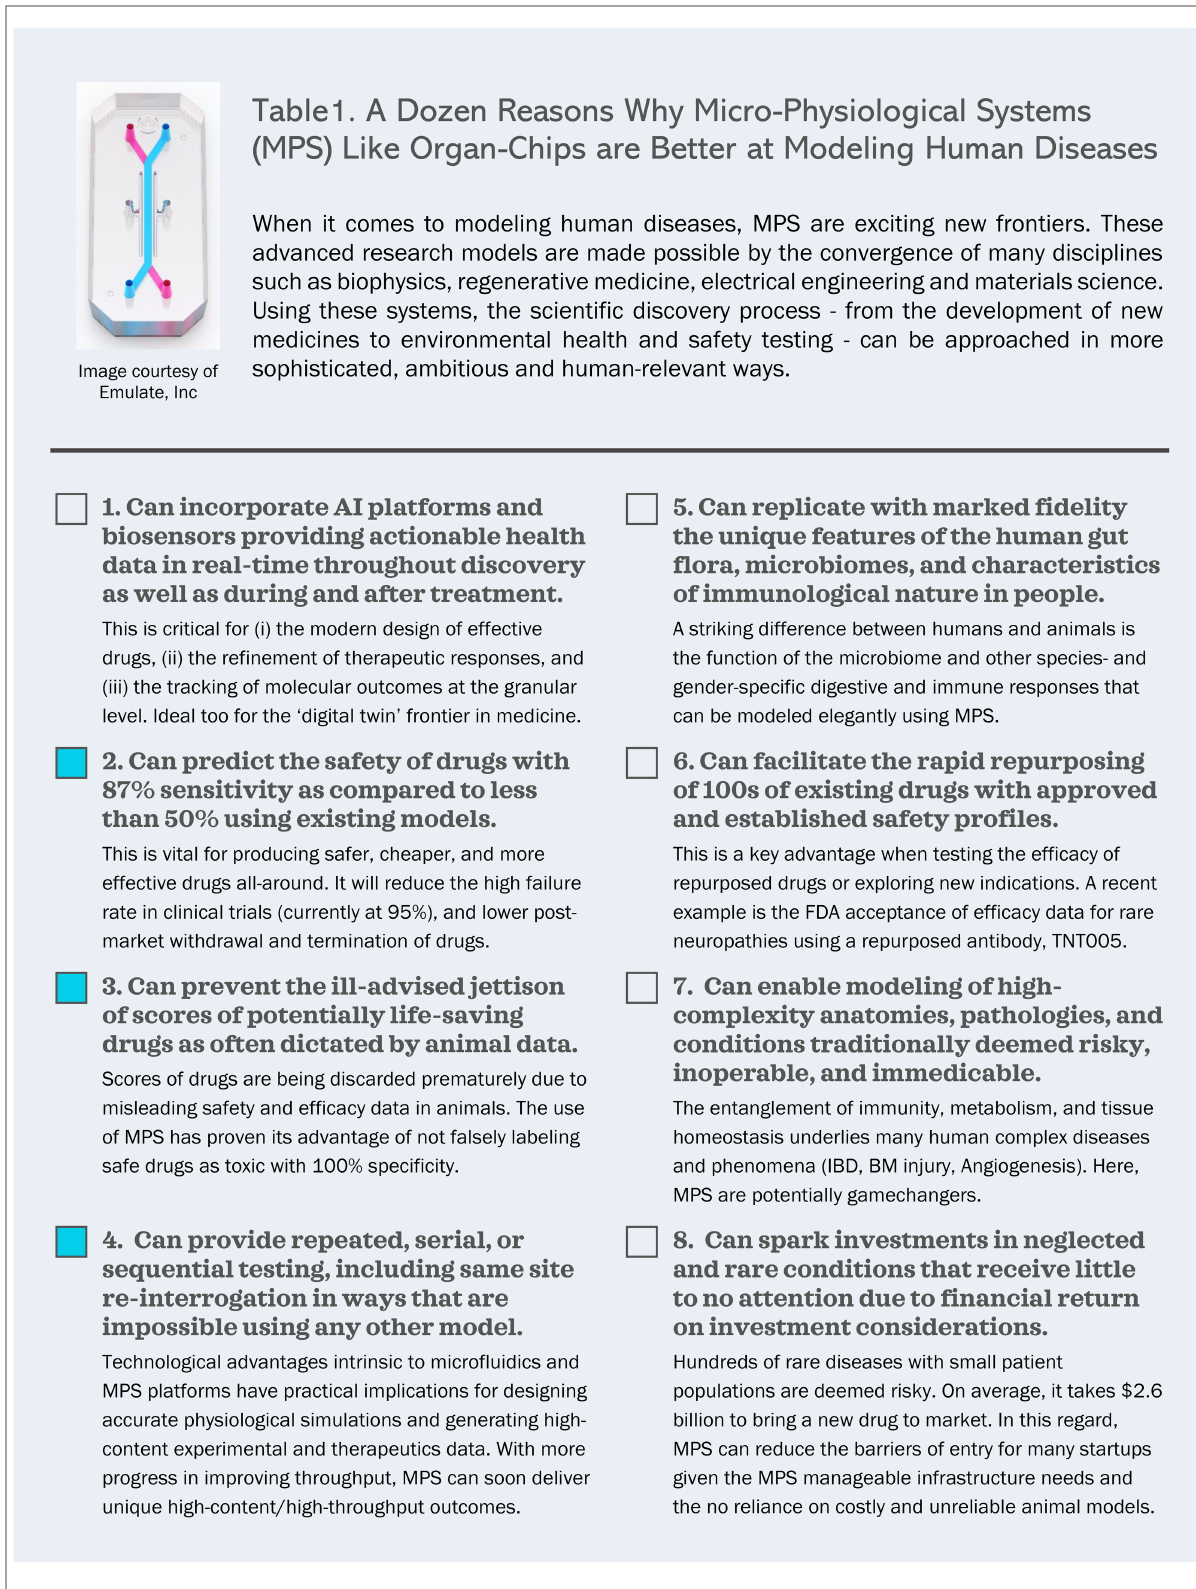
FIGURE 1 A dozen reasons why micro-physiological systems (MPS) like organ-chips are better at modeling human diseases. AI: Arti fi cial Intelligence; IBD: In fl ammatory Bowel Disease; BM Injury: Bone Marrow Injury. Filled squares represent aspects directly related to Ewart et al., reviewed in this opinion